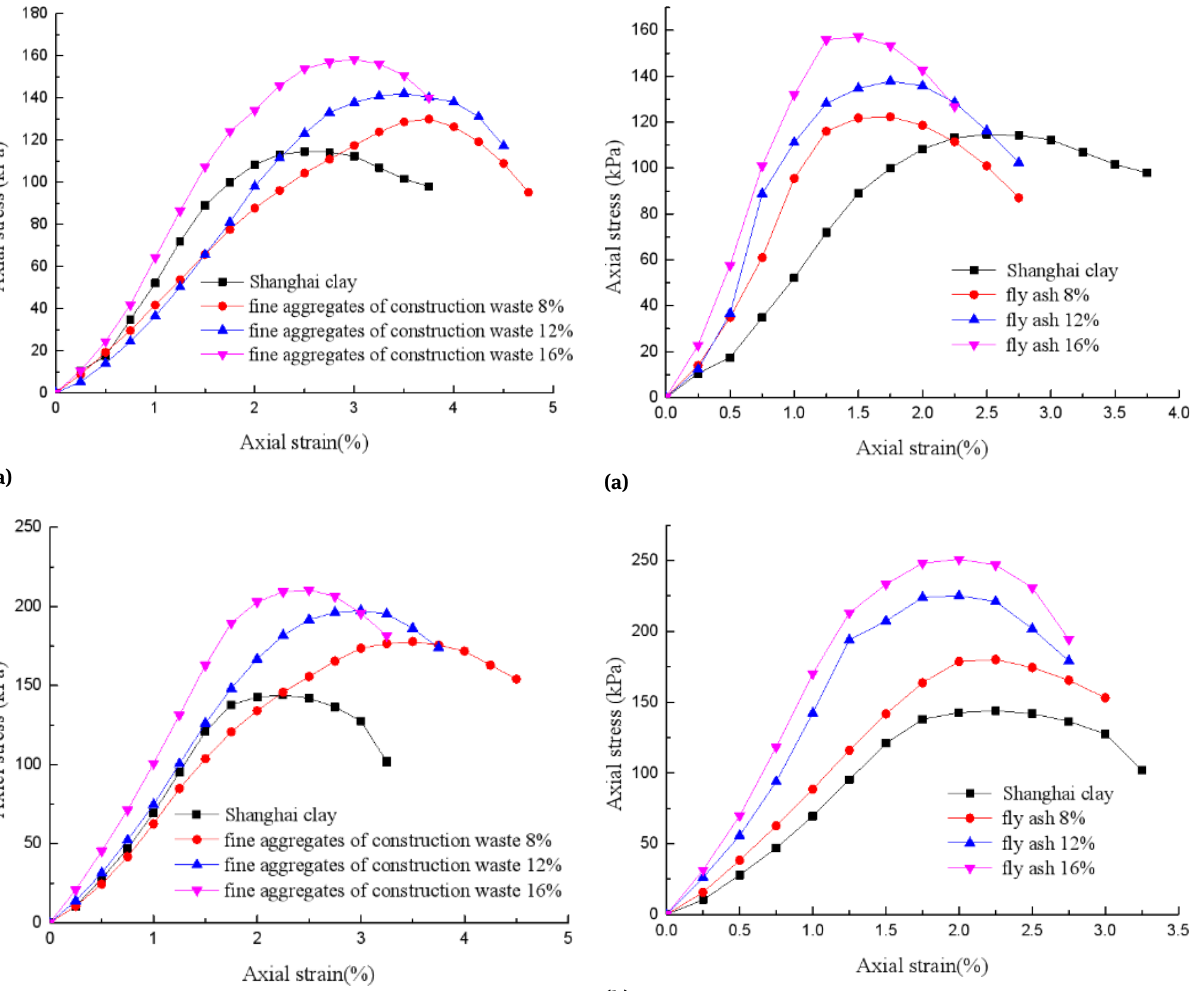
Figure 7: Stress-strain curve of soil reinforced with fly ash for 7 d (a) and 28 d